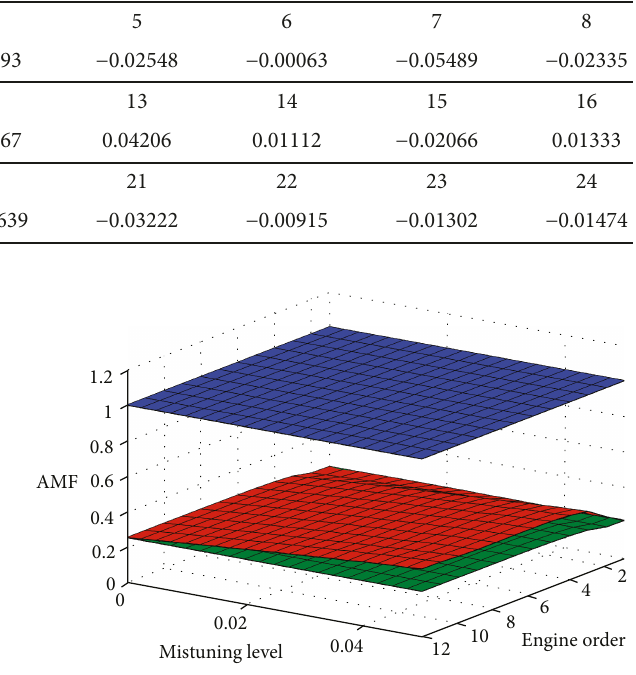
Figure 18: Estimations of AMFs corresponding to di ff erent conditions (blue: tuned blisk without SSDNC; green: tuned blisk with tuned SSDNC; red: tuned blisk with mistuned